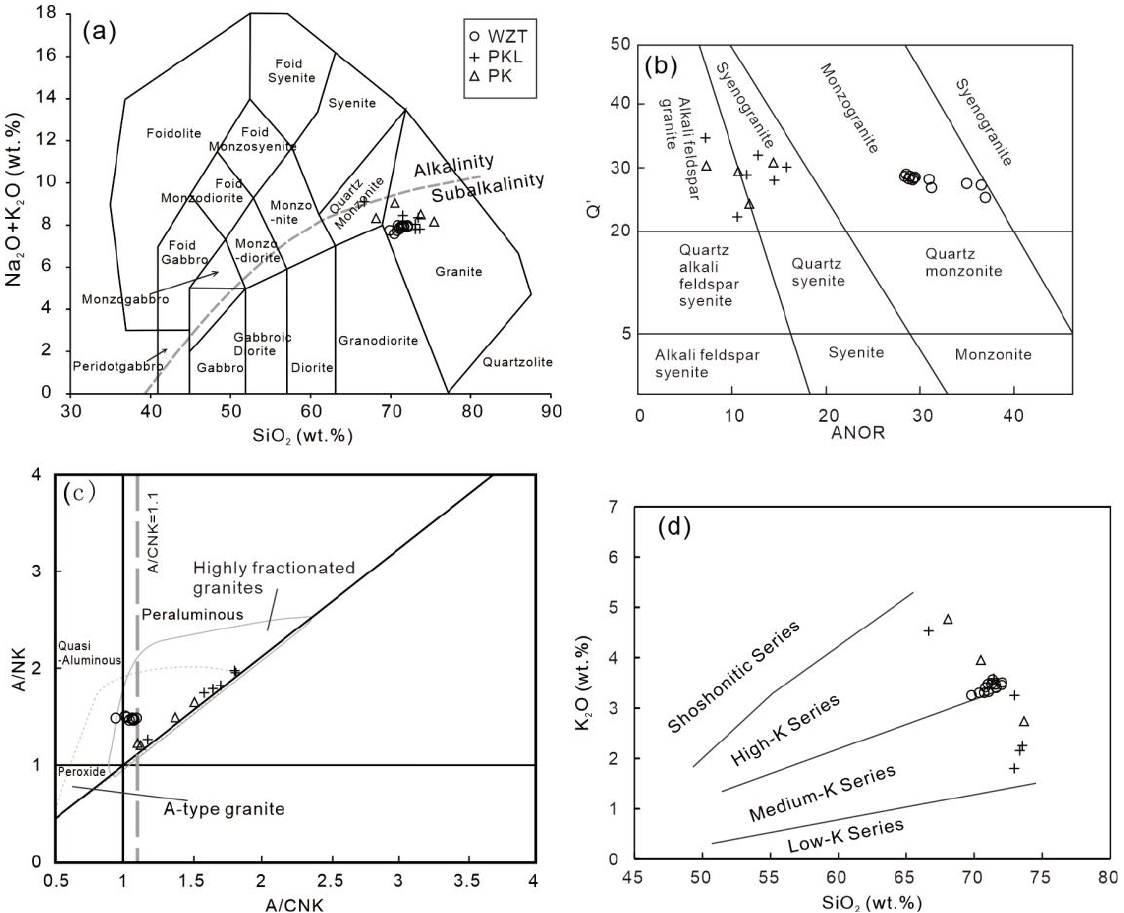
Figure 6. ( a ) TAS diagram (after [55]) of the Wuzhutang granite from the Xuebaoding mining area, Sichuan Province, China. ( b ) ANOR vs. Q’ diagram (after [56]) of the Wuzhutang granite. ( c ) A/CNK vs. A/NK diagram (after [57]) of the Wuzhutang granite. Data of A-type granite and highly fraction- ated granites are from [44]. ( d ) SiO 2 vs. K 2 O diagram (after [57]) of the Wuzhutang granite. Data of the Pankou and Pukouling granites are from [38,39]. Table 3. Analysis results of the major (wt.%) and trace (ppm) elements of the Wuzhutang granite from the Xuebaoding mining area.